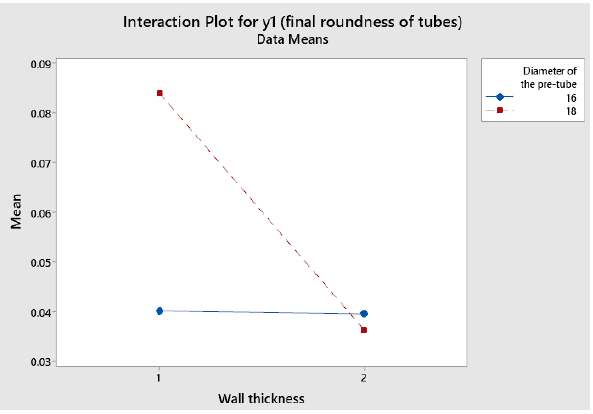
Figure 9. Interaction plot for the variable y 1 , or the final roundness of the tube, considering two categorical factors.